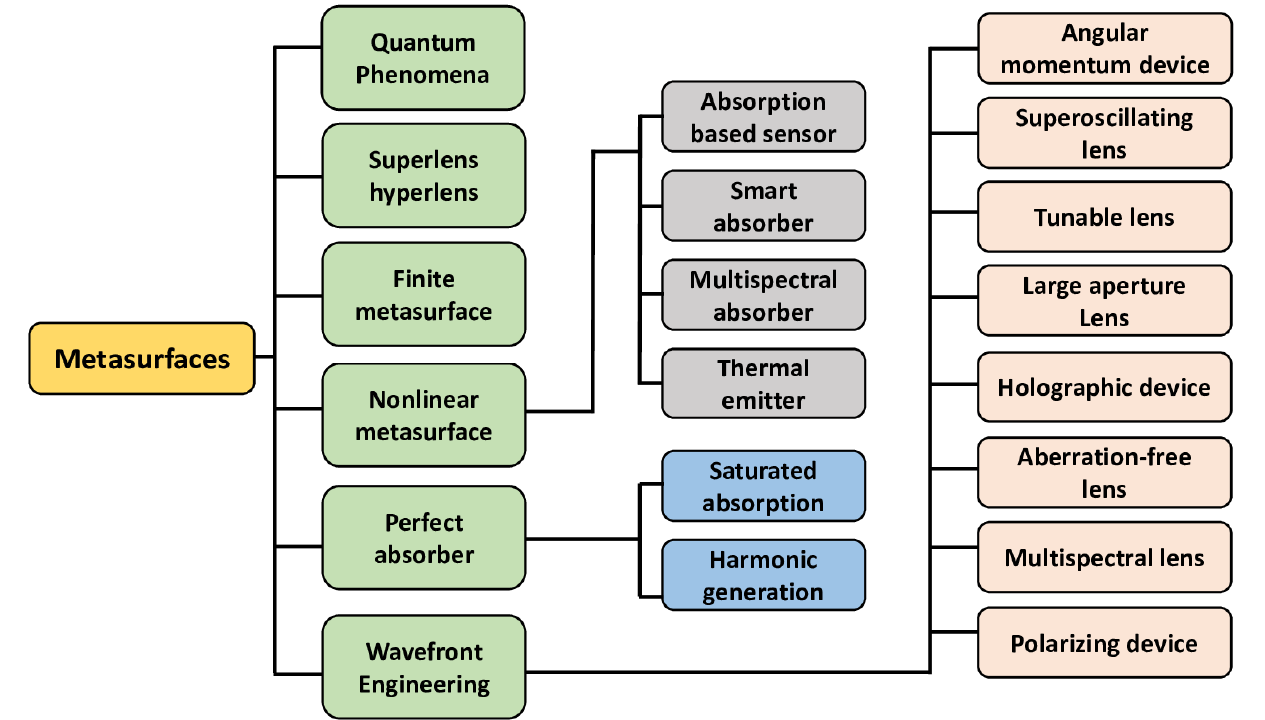
Figure 5. Chart summarizing the metasurfaces’ and metadevices’